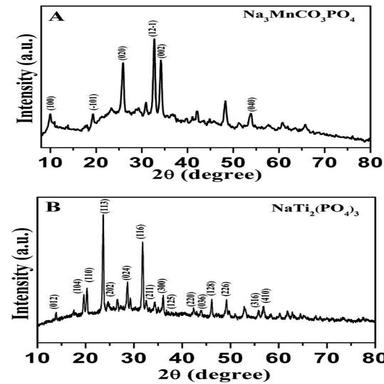
X-ray diffraction pattern of synthesized, (A) Na3MnCO3PO4 and (B) NaTi2(PO4)3.